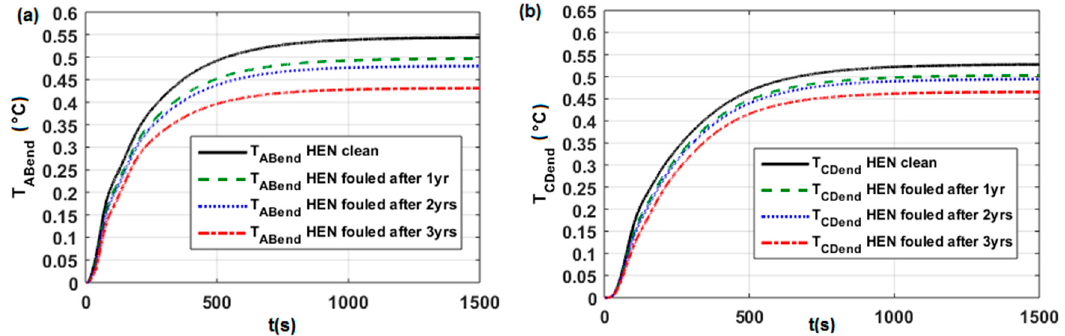
Figure 10. Open-loop responses of the HEN models (( a ) – the end temperature T ABend and ( b ) – the end temperature T CDend , after parallel branches) to +1 °C step change in the tube-side inlet temperature of the branches A and B .